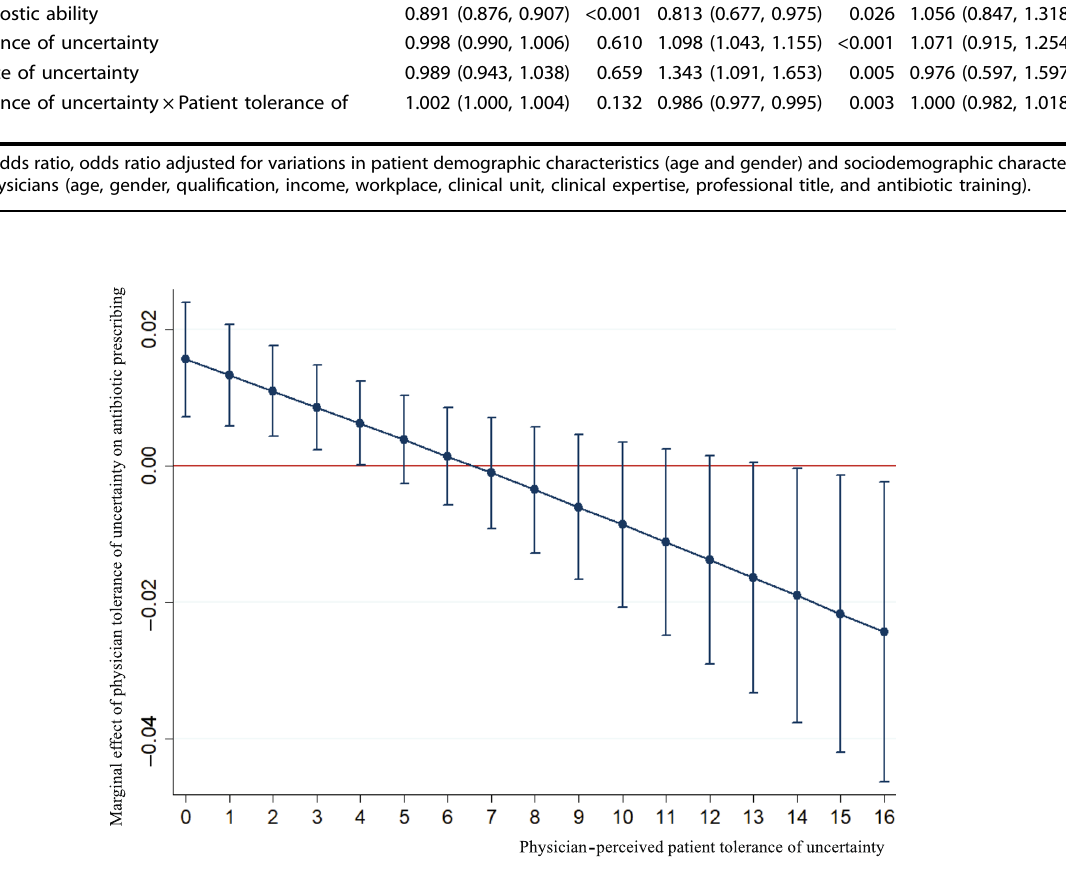
Fig. 2 The interaction effect between physician tolerance of uncertainty and patient tolerance of uncertainty on antibiotic prescribing for acute tonsillitis. This fi gure shows the interaction between physician tolerance of uncertainty and perceived patient tolerance of uncertainty regarding antibiotic use with 95% con fi dential intervals for outpatients with acute tonsillitis. Physician tolerance of uncertainty was assessed using a tolerance for ambiguity scale, with higher scores indicating lower physician tolerance of uncertainty. Patient tolerance of uncertainty was assessed based on physician estimation of patient ambiguity aversion, with higher scores indicating lower patient tolerance of uncertainty. For different perceived patient tolerances of uncertainty, the one-point decrease in physician tolerance of uncertainty played different roles. When physicians perceived high patient tolerance of uncertainty (scores ≤ 6), the lower physician tolerance of uncertainty further increased antibiotic use, while for perceived low level of patient tolerance of uncertainty (scores ≥ 7), the lower physician tolerance of uncertainty would reduce antibiotic use. However, the interaction between the physician tolerance of uncertainty and perceived patient tolerance of uncertainty on antibiotic use was only signi fi cant when perceived patient tolerance of uncertainty was ≤ 4 (marginal effect >0, p < 0.05) or ≥ 14 (marginal effect <0, p <